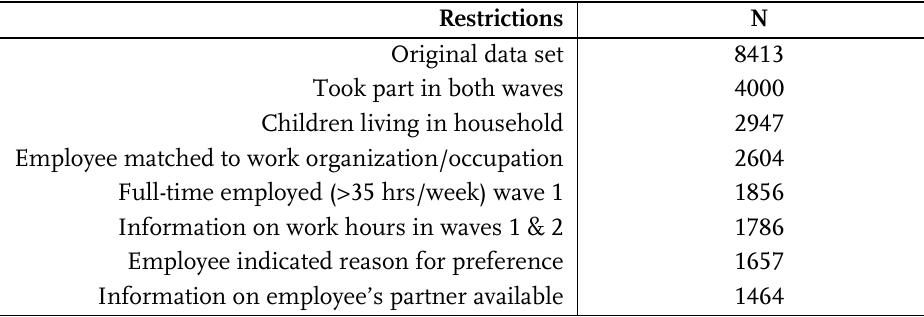
Table 1 : Case numbers following sample